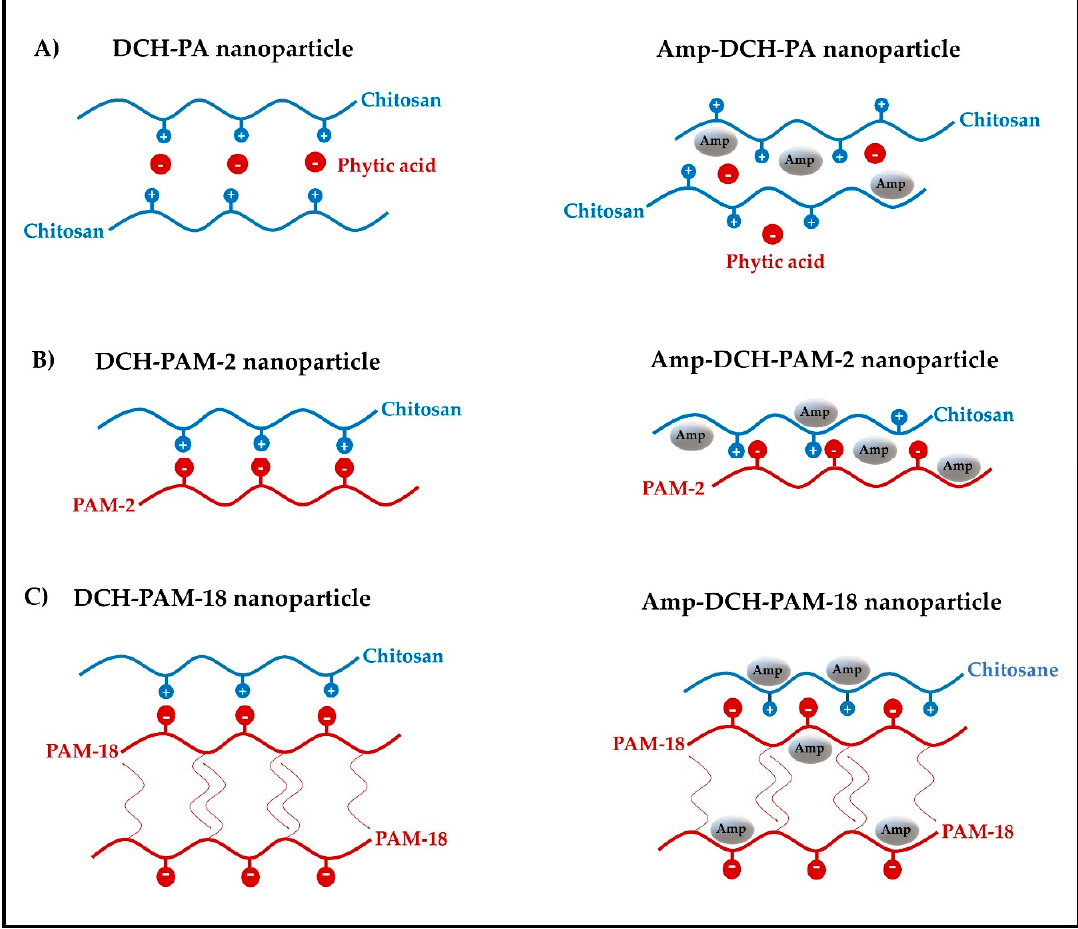
Figure 2. Schematic of the formation of chitosan–polyanion nanoparticles in blank ( left ) and ampicillin-loaded ( right ) nanoparticles. ( A ) Nanosystem formed with phytic acid. ( B ) Nanosystem formed with PAM-2. ( C ) Nanosystem formed with